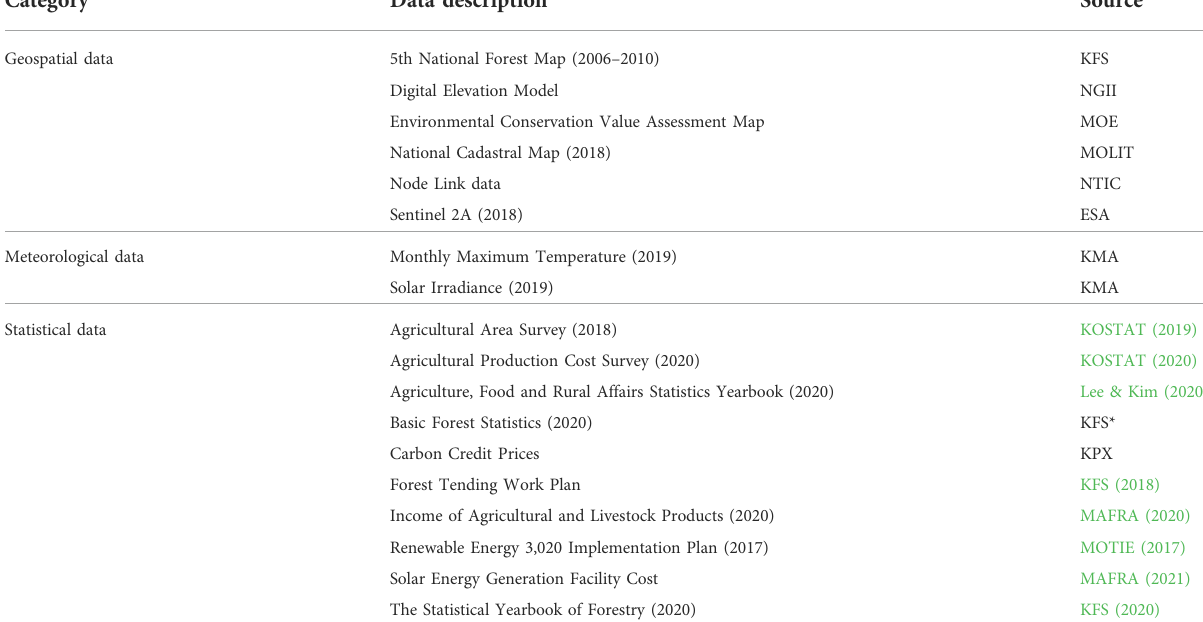
TABLE 2 Data used in the